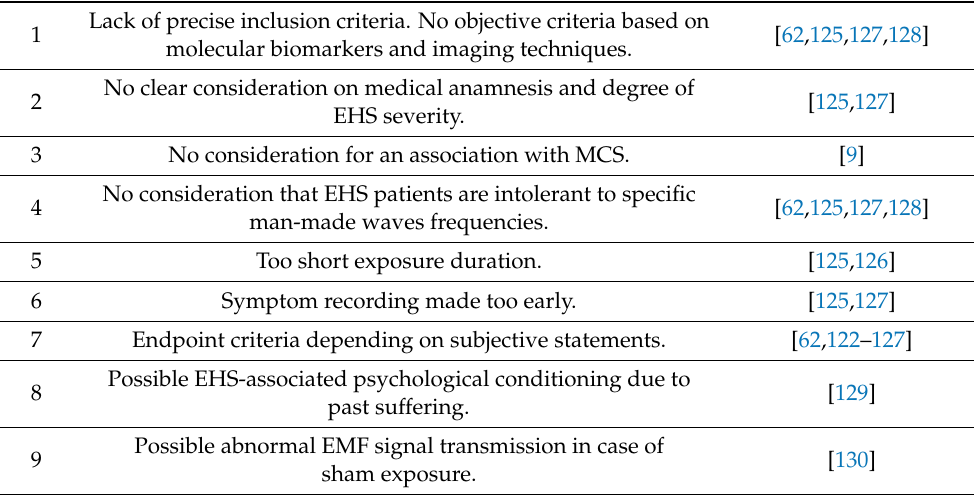
Table 1. Some methodological defects that make provocation tests unsuitable for sham versus EMF exposure analysis in EHS-bearing